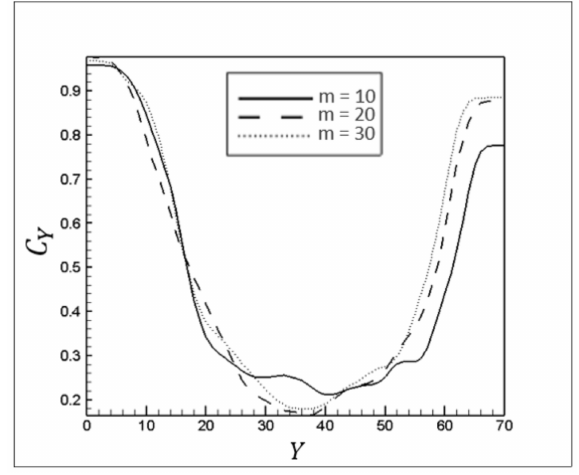
Figure 30. Longitudinal displacement efficiency over the channel height for different